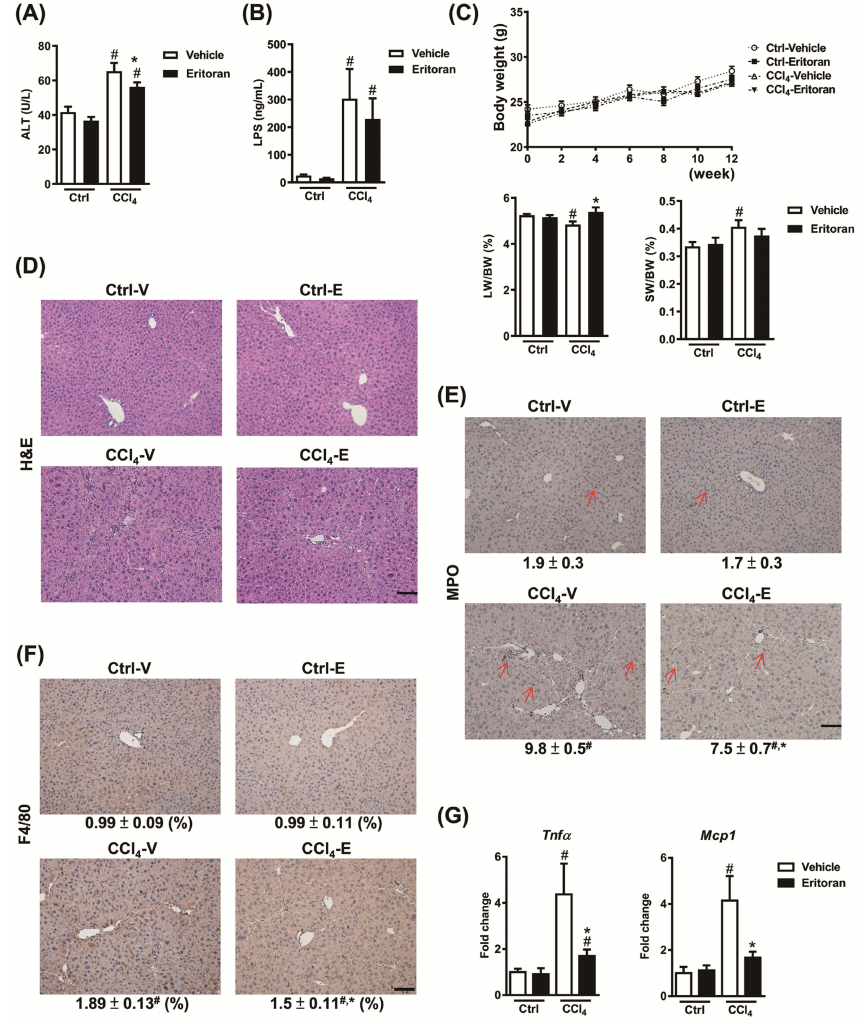
Figure 6. Eritoran decreased liver inflammation in the carbon tetrachloride (CCl 4 )-injured mice. ( A ) Serum ALT levels. ( B ) Serum LPS levels. ( C ) Liver weight (LW) and spleen weight (SW). ( D ) Hematoxylin and eosin (H&E), ( E ) myeloperoxidase (MPO) staining and ( F ) immunohistochemical staining for F4/80 of the liver sections and quantification of the MPO-positive stained cells (arrow) as well as the positively stained F4/80 areas (%). Scale bar = 100 µ m. Tissue sections from all the